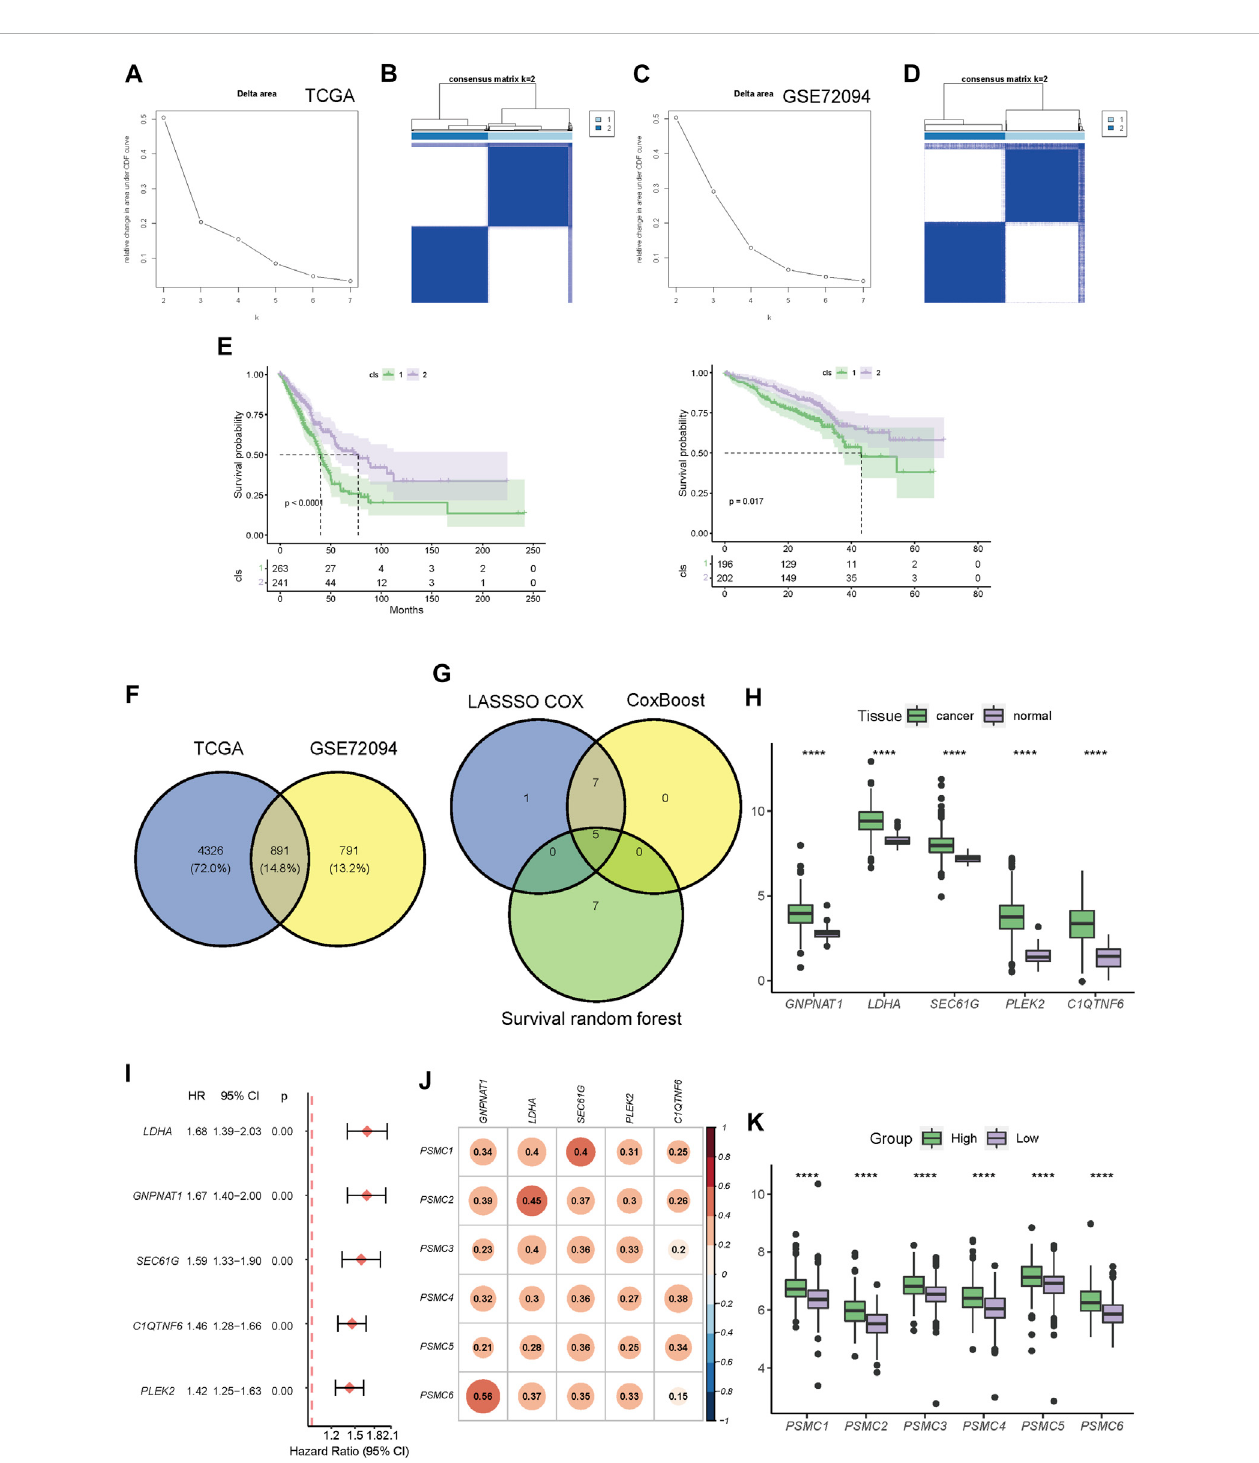
FIGURE 4 Construction of a PSMC gene-based prognostic signature. (A) CDF plot displaying the consensus distribution and the relative changes in the area under theCDFcurveintheTCGA-LUADcohort. (B) Consensusmatrixheat mapdepicting consensus valueson awhiteto bluecolorscale inTCGA-LUADdatabase. (C) CDFplotdisplayingtheconsensus distributionandtherelativechangesintheareaundertheCDFcurveintheGSE72094 cohort.Y-axis,relativechangein the area under the CDF curve and y-axis; k, the number of consensus clusters. (D) Consensus matrix heat map depicting consensus values on a white to blue color scale in the GSE72094 cohort. (E) Kaplan – Meier curves showing the overall survival of patients in different clusters in TCGA (left) and GSE72094 (right)cohorts. (F) Vennplotshowingtheoverlappedcluster-relatedDEGsbetweentheTCGAandGSE72094 cohorts. (G) Vennplotrevealingtheoverlapped candidategenesfoundusingLASSO-Cox,CoxBoost,andsurvivalrandomforest. (H) Differenceintheexpressionlevelofscreened-outgenesbetweentumor and normal tissues. (I) Forest plot of the hazard ratio (HR) of the candidate genes. (J) Pearson ’ s correlation coef fi cient between the expression levels of PSMC family genes and candidate genes. (K) Differences in the expression levels of PSMC family genes between high- and low-risk groups. Patients with LUAD in TCGA cohort were dichotomized according to the median risk score. *** p <